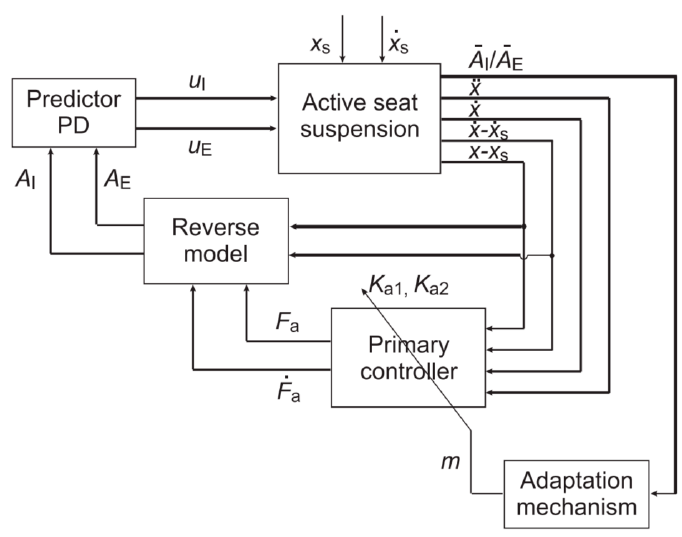
Figure 7. Schematic of the multicontroller [54].